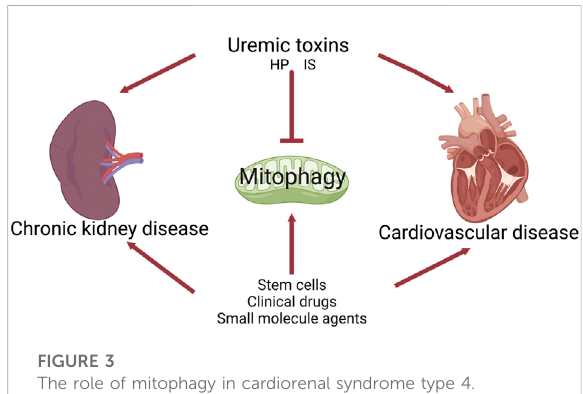
FIGURE 3 The role of mitophagy in cardiorenal syndrome type